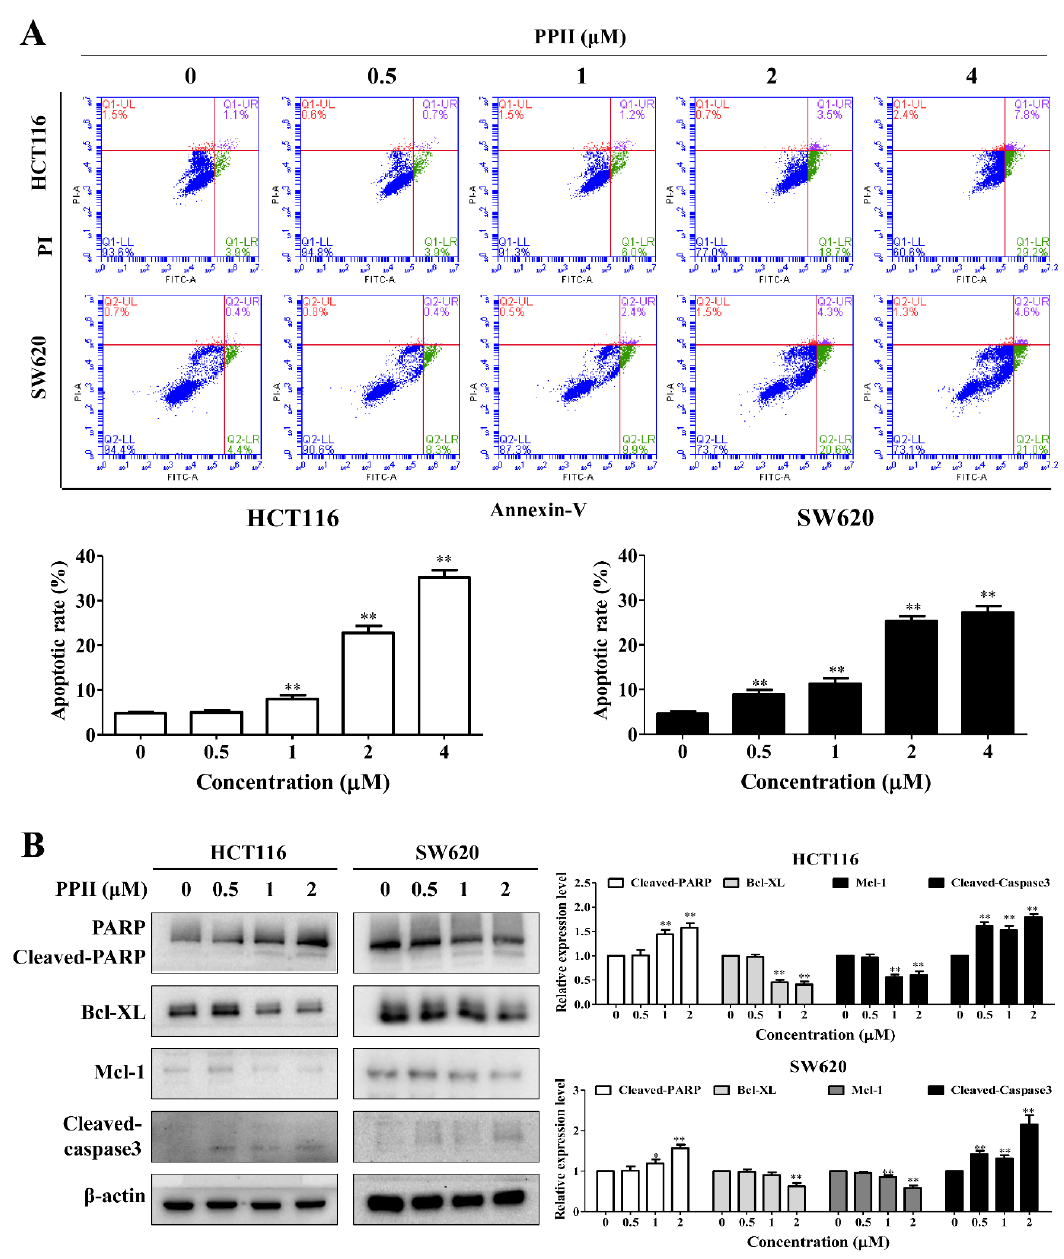
Figure 3. PPII induces apoptosis in CRC cells. The HCT116 and SW620 cells were treated with various concentrations of PPII for 24 h. ( A ) Apoptosis was analyzed using flow cytometry after annexin V/PI double-staining. ( B ) The protein levels of PARP, Mcl-1, Bcl-XL, and cleaved-caspase3 were examined using Western blotting. The left panels show the representative Western blotting results, and the right panels show the quantitative results. The data are presented as the means ± SD of three independent experiments. ** p < 0.01 vs. vehicle